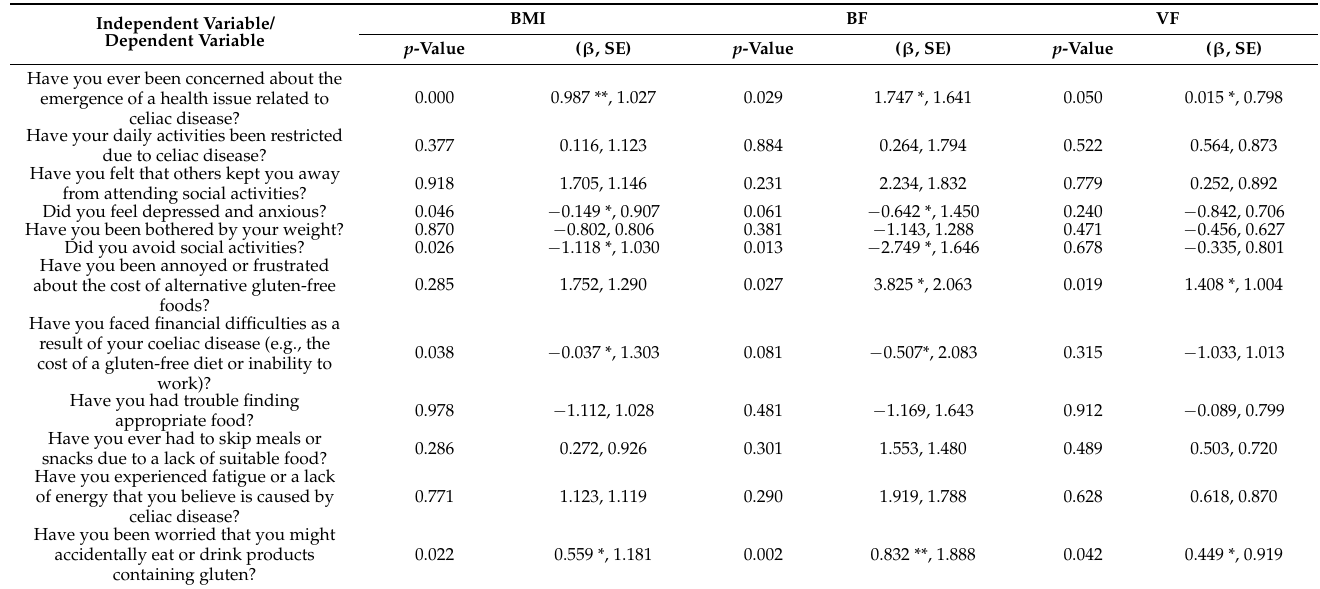
Table 6. Pearson correlation coefficients between some psychosocial queries and body mass index (BMI), body fat (BF), and visceral fat (VF) of females with CD ( n = 51).